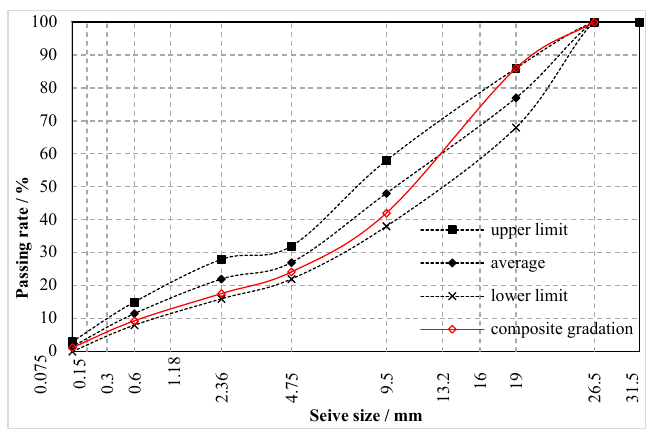
Figure 4. Mixture gradation.